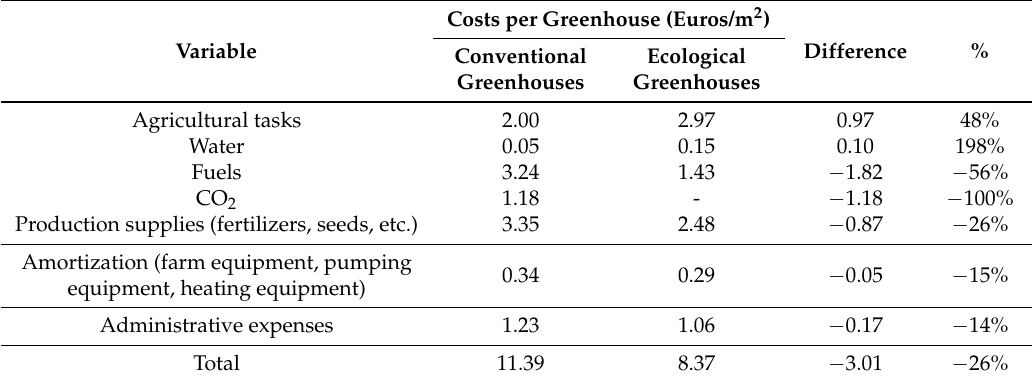
Table 4. Average operational costs in greenhouses 2002–2015. Source: fieldwork.